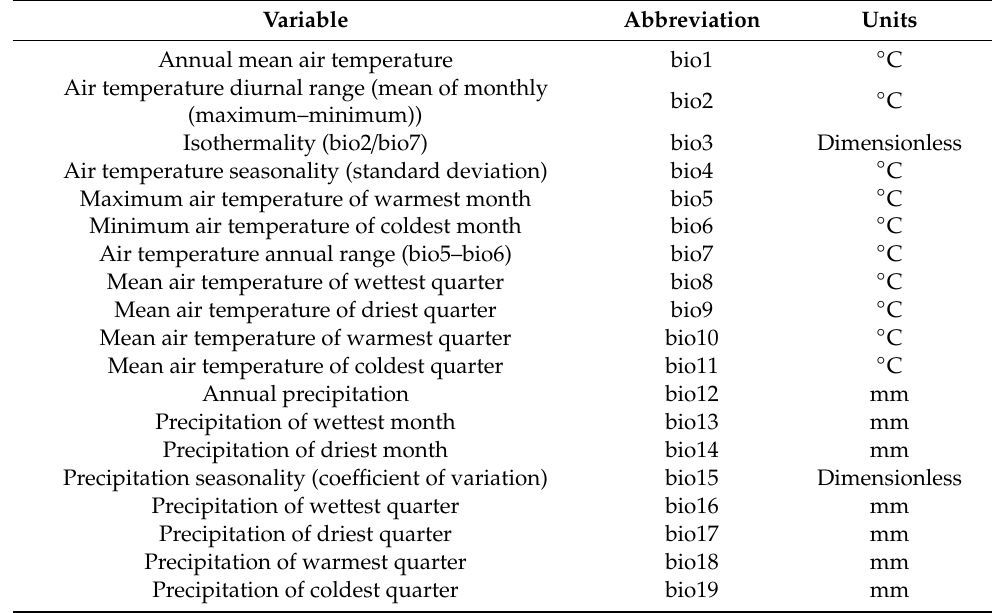
Table 1. Bioclimatic data downloaded from the WorldClim database. Variable Abbreviation